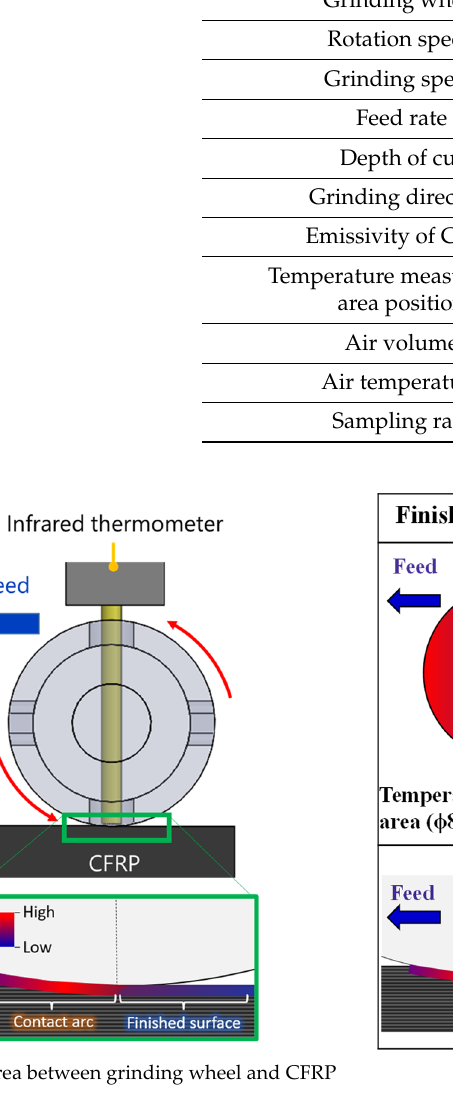
Figure 11. Setting the position of the infrared thermometer.